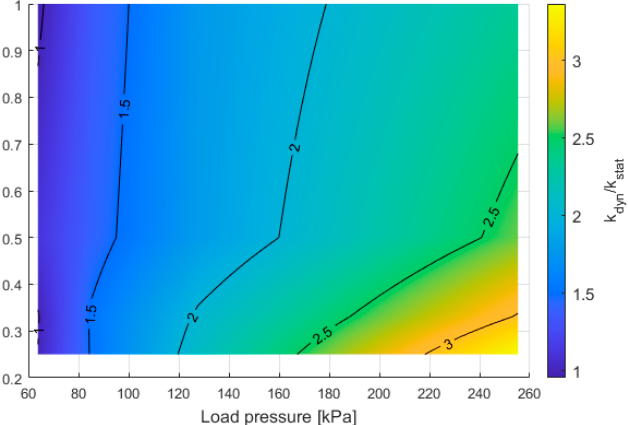
Figure 15. Relationship between the load pressure on the sample with its shape factor and k dyn / k stat .